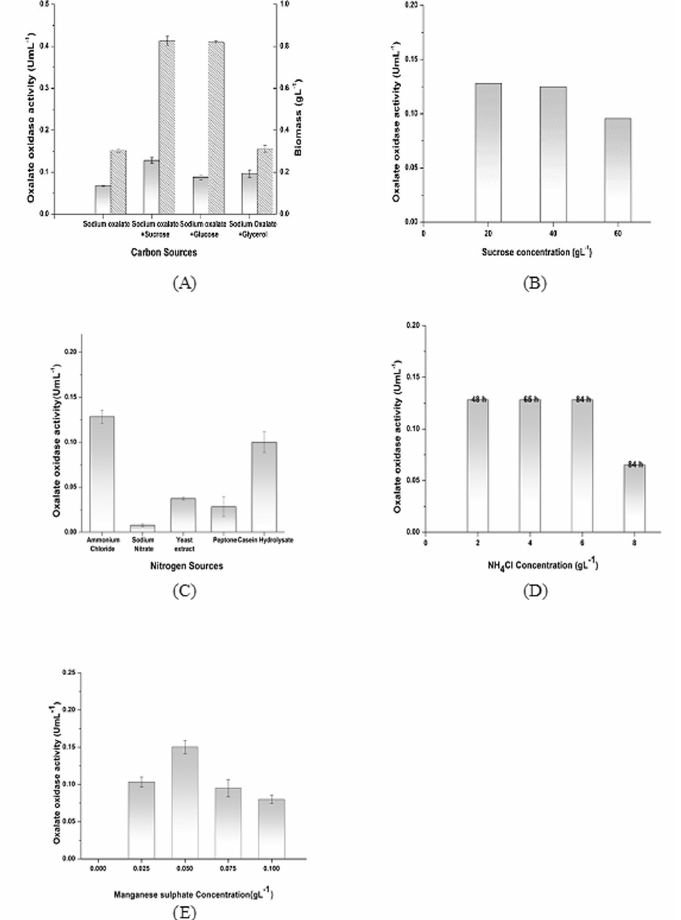
Fig. 2. Effect of nutritional parameters on biomass growth and enzyme production. (A) Effect of various sugars in medium on biomass growth () and enzyme activity (). Medium contains 20 gL -1 carbon source, 5 gL -1 Sodium oxalate and 2 gL -1 NH Cl along with basal salts. (B) Effect of sucrose concentration on the enzyme activity was studied by 4 changing its concentration in the medium having 5 gL -1 Sodium oxalate and 2 gL -1 NH Cl along with basal salts. (C) 4 Effect of various nitrogen sources in medium on enzyme production was studied. The medium contains 20 gL -1 of sucrose as carbon source, 2 gL -1 nitrogen source and 5 gL -1 sodium oxalate as inducer along with basal salts. (D) Effect of NH Cl Concentrations on oxalate oxidase activity was studied by changing its concentration in the 4 medium having 20 gL -1 of sucrose and 5 gL -1 sodium oxalate along with basal salts. (E) Effect of MnSO on enzyme 4 production was studied by changing its concentration in medium having 20 gL -1 of sucrose, 5 gL -1 sodium oxalate and 2 gL -1 NH Clalong with basal salts. Control had no MnSO in the 4 4